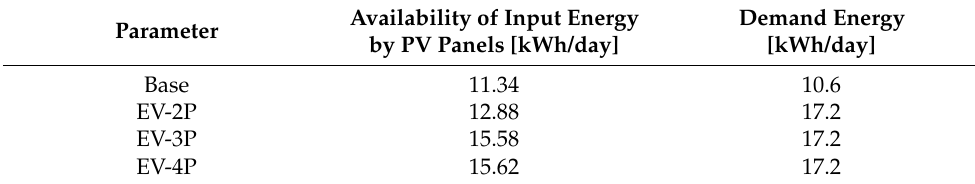
Table 4. Energy generation and demand for different scenarios for the proposed day.